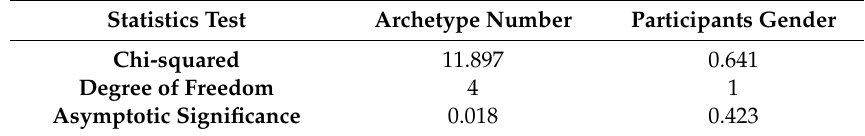
Table 15. Chi-Square value for equal proportions of participants by behavioural archetype and